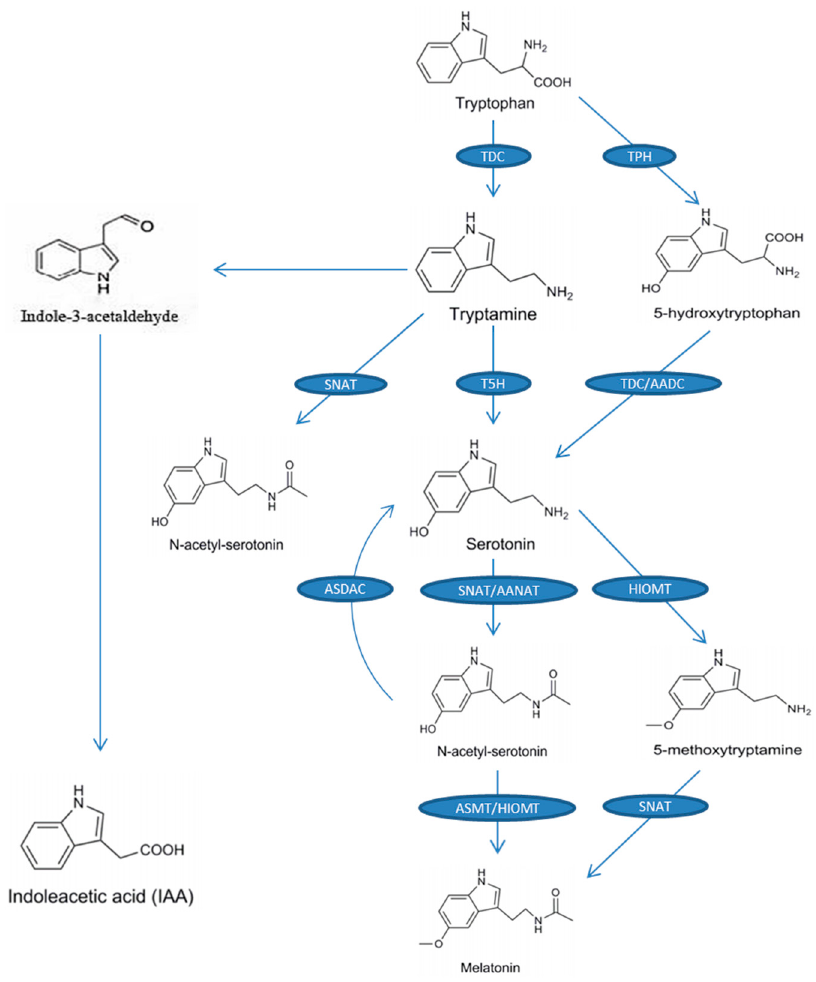
Figure 1. Biosynthetic pathway of melatonin from tryptophan in plants. The enzymes of the respective